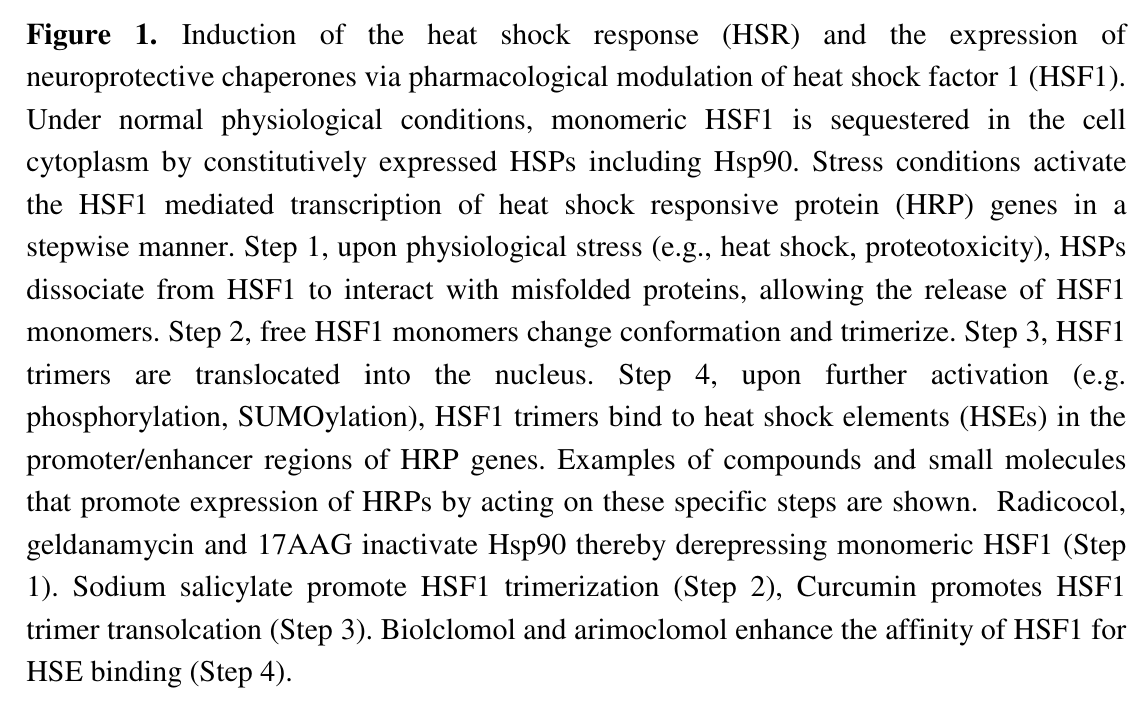
Figure 1. Induction of the heat shock response (HSR) and the expression of neuroprotective chaperones via pharmacological modulation of heat shock factor 1